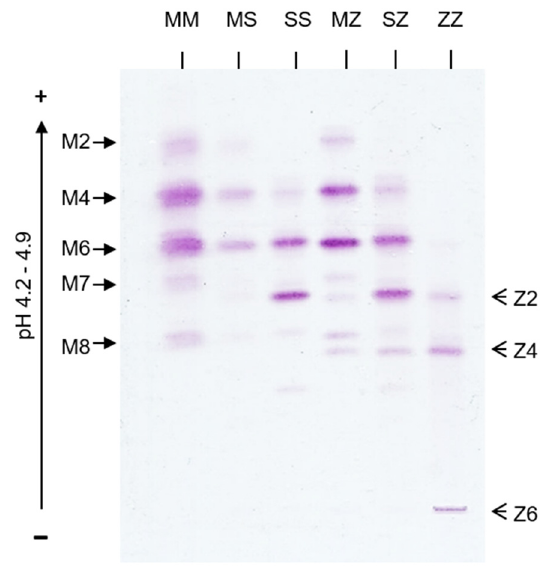
Figure 2. Isoelectric focusing patterns of AAT phenotypes. Healthy control MM AAT glycoforms (M2–M8) are denoted on the left. Glycoforms from an AATD patient homozygous for the Z allele (Z2, Z4 and Z6) are shown on the right.